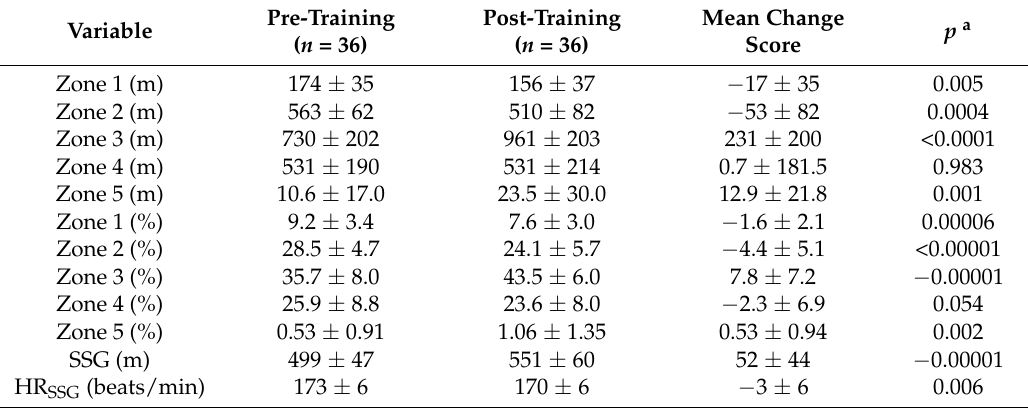
Table 2. Distance covered by soccer players in individual zones, percentage (%) of their share in relations to total distance, average distance (m) and intensity (HR) of effort in four small-sided games (SSG).